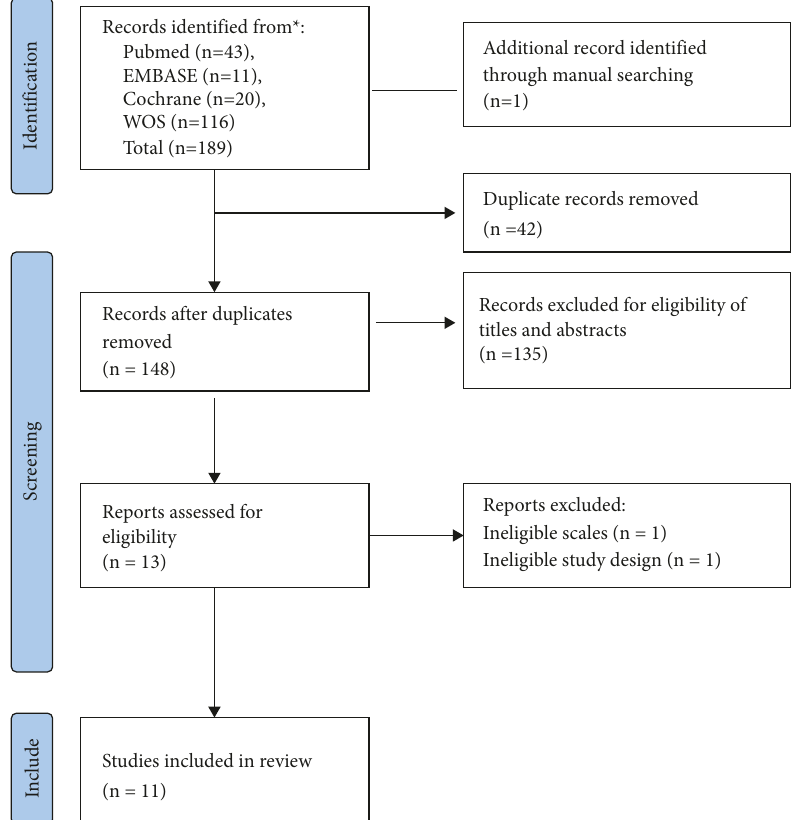
Figure 2: Flow diagram of selection progress for